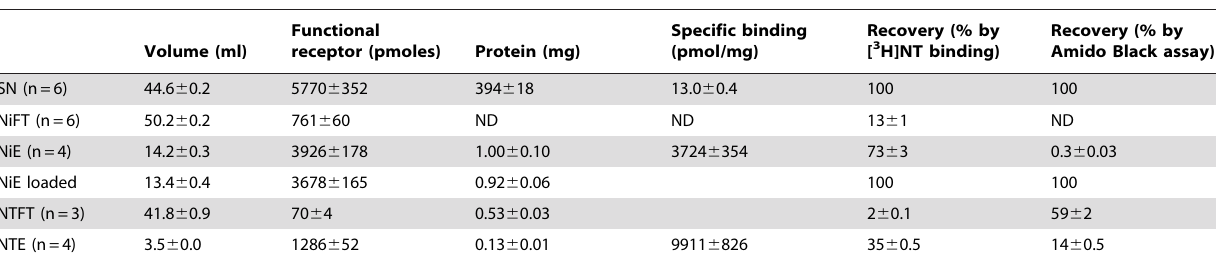
Table 3. Purification of NTS1.